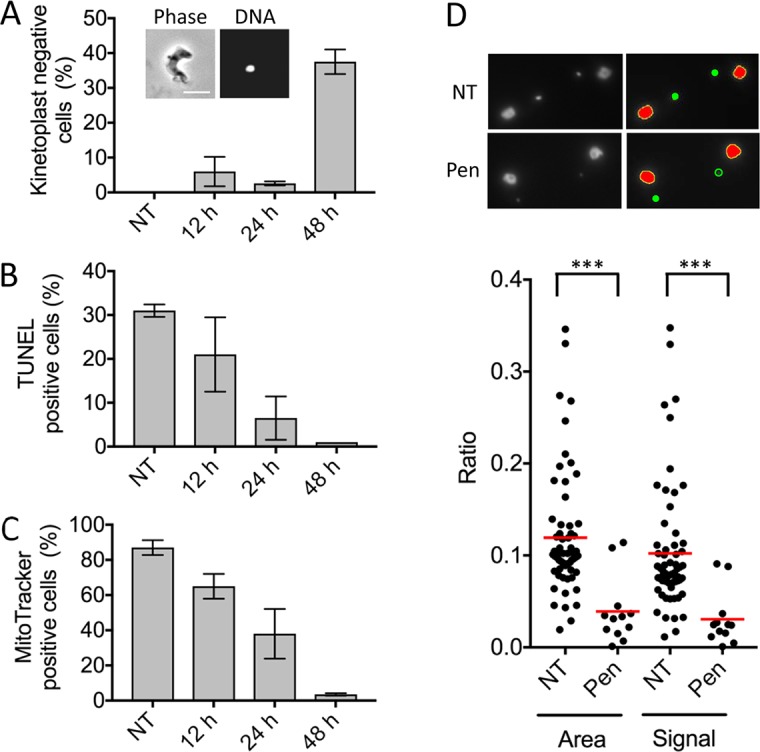
Pentamidine induces progressive loss of kinetoplast DNA.Effects of pentamidine treatment for 12, 24 and 48 h on (A) percentage of kinetoplast negative cells, (B) percentage of TUNEL-positive cells and (C) percentage of extended Mitotracker signal positive cells. The inset in A shows an example of a cell with no detectable kinetoplast DNA; error bars, SD; N = 2; scale bar, 5μm. (D) ImageJ analysis. Raw images (left hand panels) and ImageJ outputs (right hand panels) demonstrating that kinetoplasts fall below the threshold of detection (open green circle). Ratios of kinetoplasts to nuclei, total area and total signal (area multiplied by mean intensity) are plotted for cells with detectable kinetoplasts. Red lines, averages; ***, P < 0.001 from Students t-test.